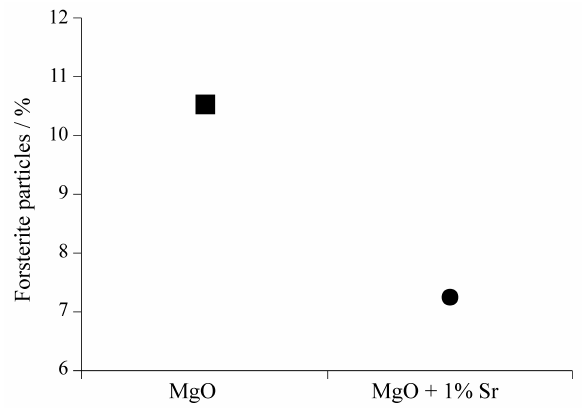
Figure 4. Volume fraction of forsterite particles in the film formed by MgO and MgO + 1% Sr.